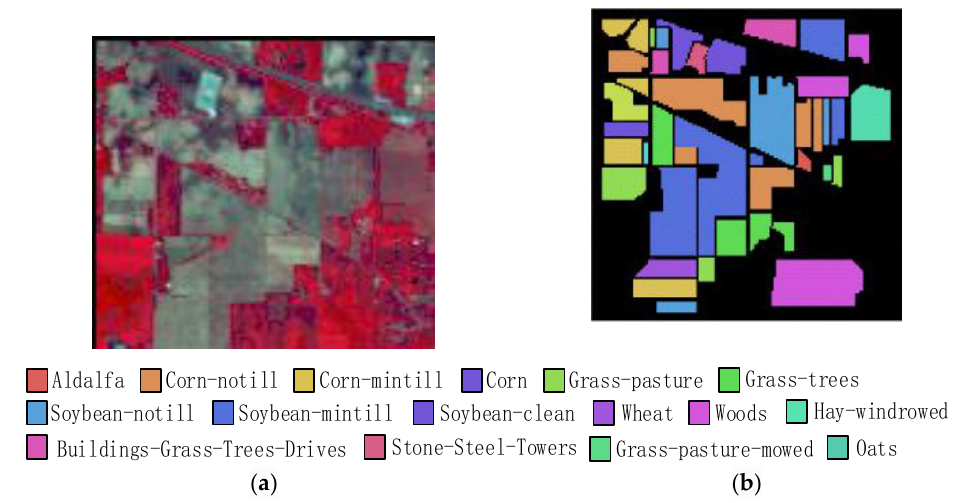
Figure 8. Indian Pines dataset, ( a ) original image, ( b ) mark map of real ground objects. Table 3. Training validation and testing sample numbers in Indian Pines .